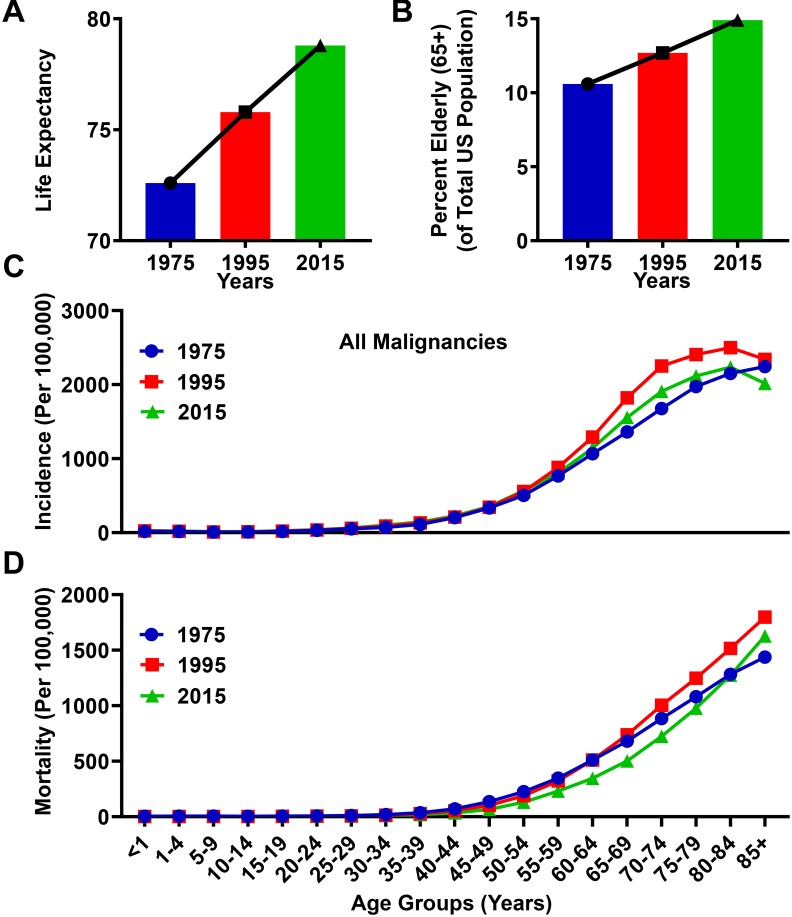
Progressive aging is associated with an increased rate of cancer incidence and mortality. (A) Life expectancy from the Center for Disease Control and Prevention (CDC) database for an average lifespan in the United States between the years 1975 and 2015. (B) Population data from the Surveillance, Epidemiology, and Ends Results (SEER) database representing the total number of elderly human subjects (ages ≥65) divided by the total population in the United States for the years 1975, 1995, and 2015. (C) Incidence and (D) mortality rates from the SEER database for all malignancies in the years 1975, 1995, and 2015. Rates are defined as number of cases and deaths, respectively, divided by the population in each age category and multiplied by 100,000 people (per 100,000).